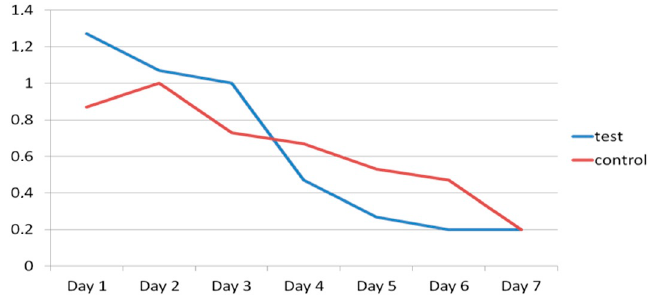
Figure 17. Evolution of rescue analgesics taken in test group (blue) and control group (red) during the seven days after surgery.